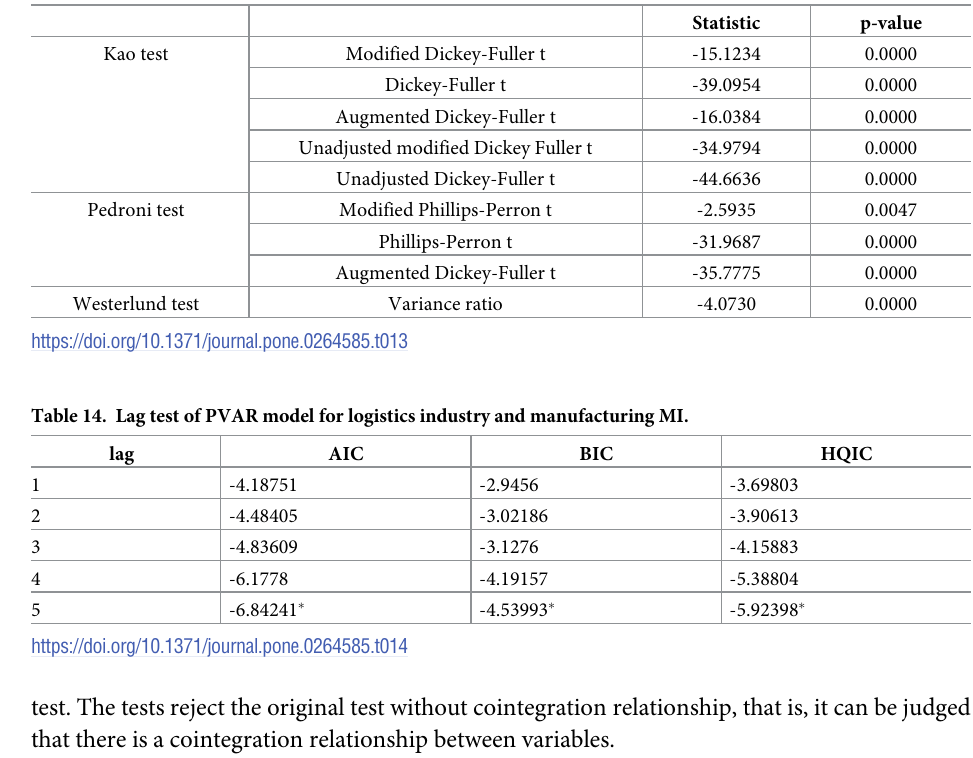
Table 13. Cointegration test of logistics industry and manufacturing MI.